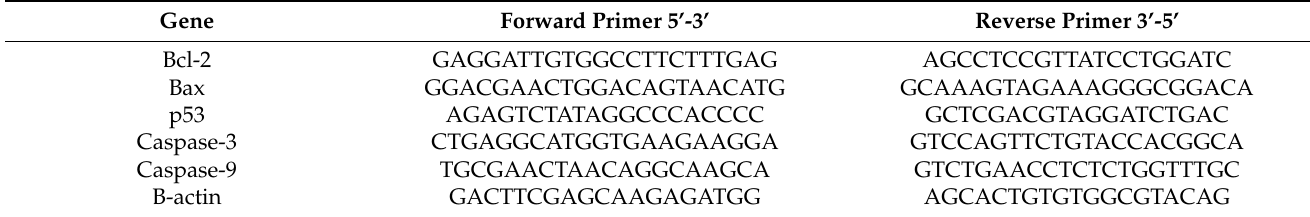
Table 1. Primer sequences used for